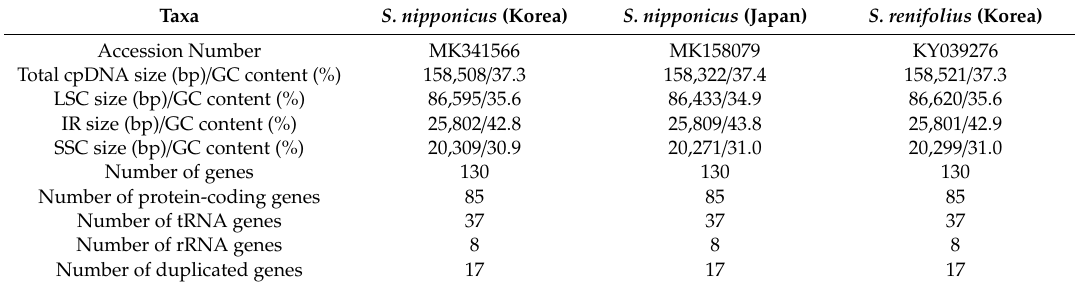
Table 1. Summary statistics of two accessions of Symplocarpus nipponicus and S. renifolius